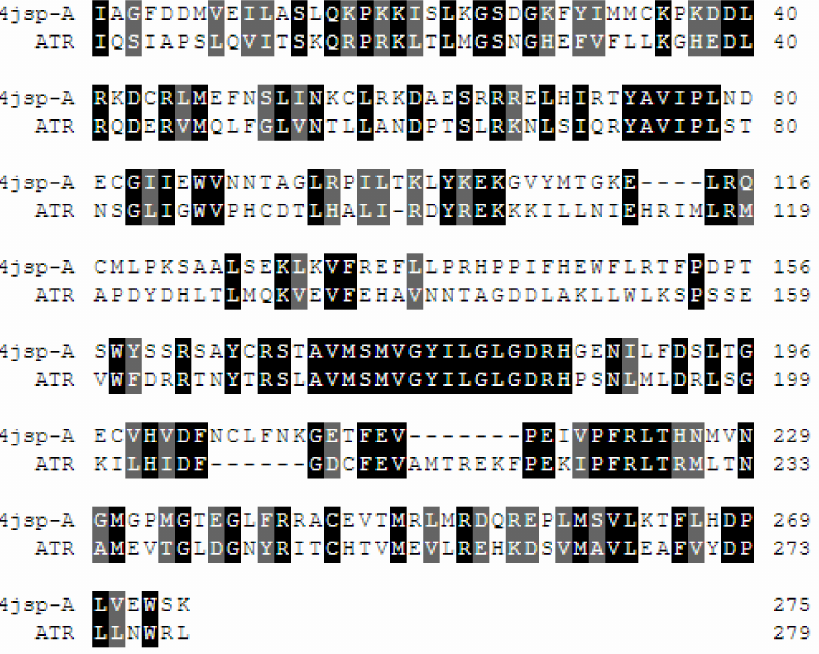
Figure 2. Pairwise alignment of 4JSP_A and ATR kinase.